Question: Condense the content of this figure into a single sentence.
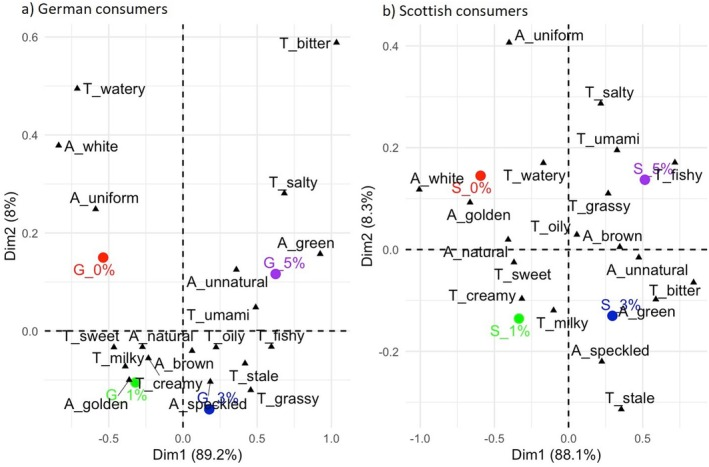
Answer: Correspondence analysis based on the appearance (A) and taste (T) CATA data from the sensory evaluation of the oat‐banana‐drinks with 0% (red), 1% (green), 3% (blue), and 5% (purple) seaweed in (a) Germany (G; n = 61) and (b) Scotland (G; n = 59).